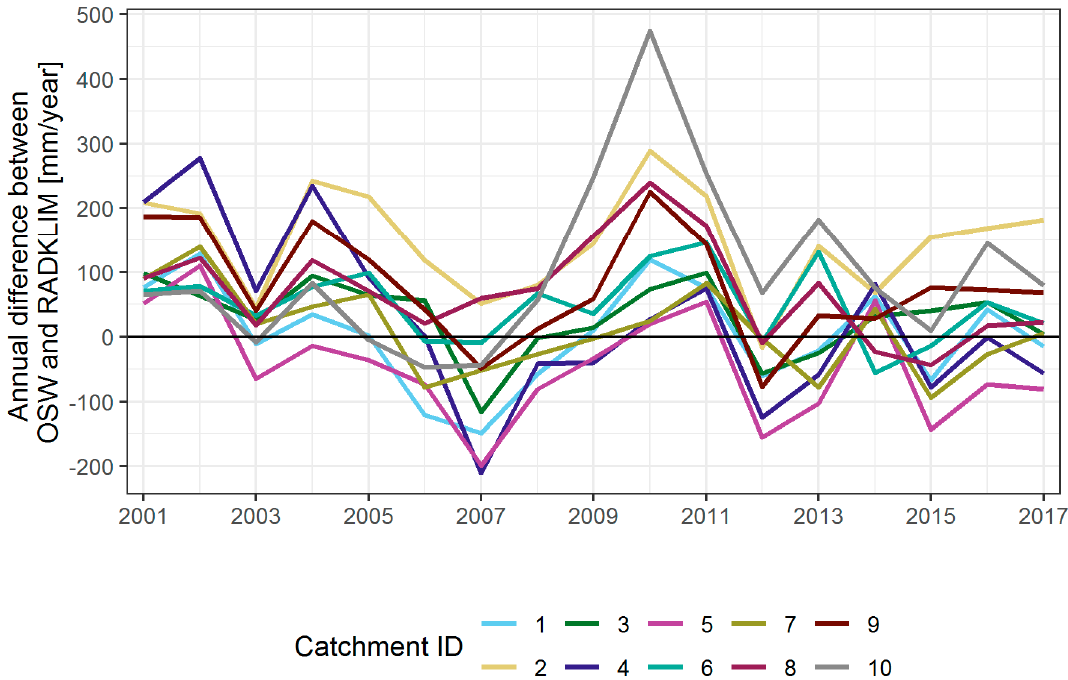
Figure 6. The absolute difference between annual precipitations derived from OSW and RADKLIM for the ten selected catchments in the study period 2006–2017.